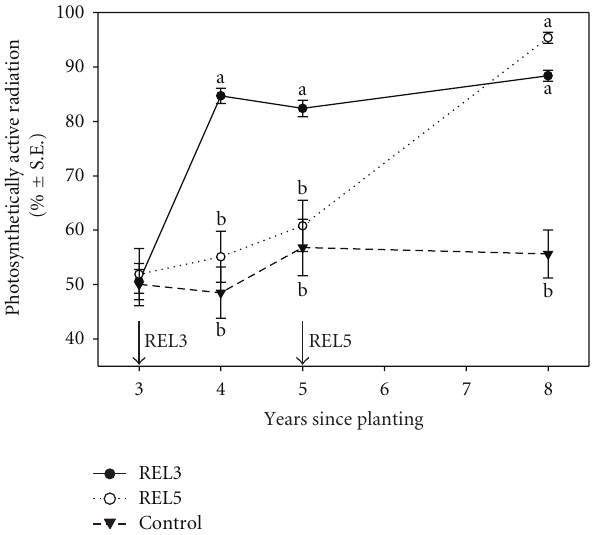
Figure 7: Average percent of full sunlight (%PAR) reaching the upper half of large containerized and bareroot Picea glauca seedlings outplanted in south central Quebec (Canada) over eight growing seasons. %PAR was assessed based on the method described by Jobidon [30]. Treatments consisted of four intensities of vegetation management, including a control, mechanical release during the third growing season (REL3), and mechanical release during the fifth growing season (REL5). The fourth treatment (No competi- tion; NC) was not included in the analyses, as by definition it con- sisted of the complete elimination of any competition for light, using repeated herbicide and mechanical release treatments. Values were therefore 100% under the NC treatment over the entire experimental